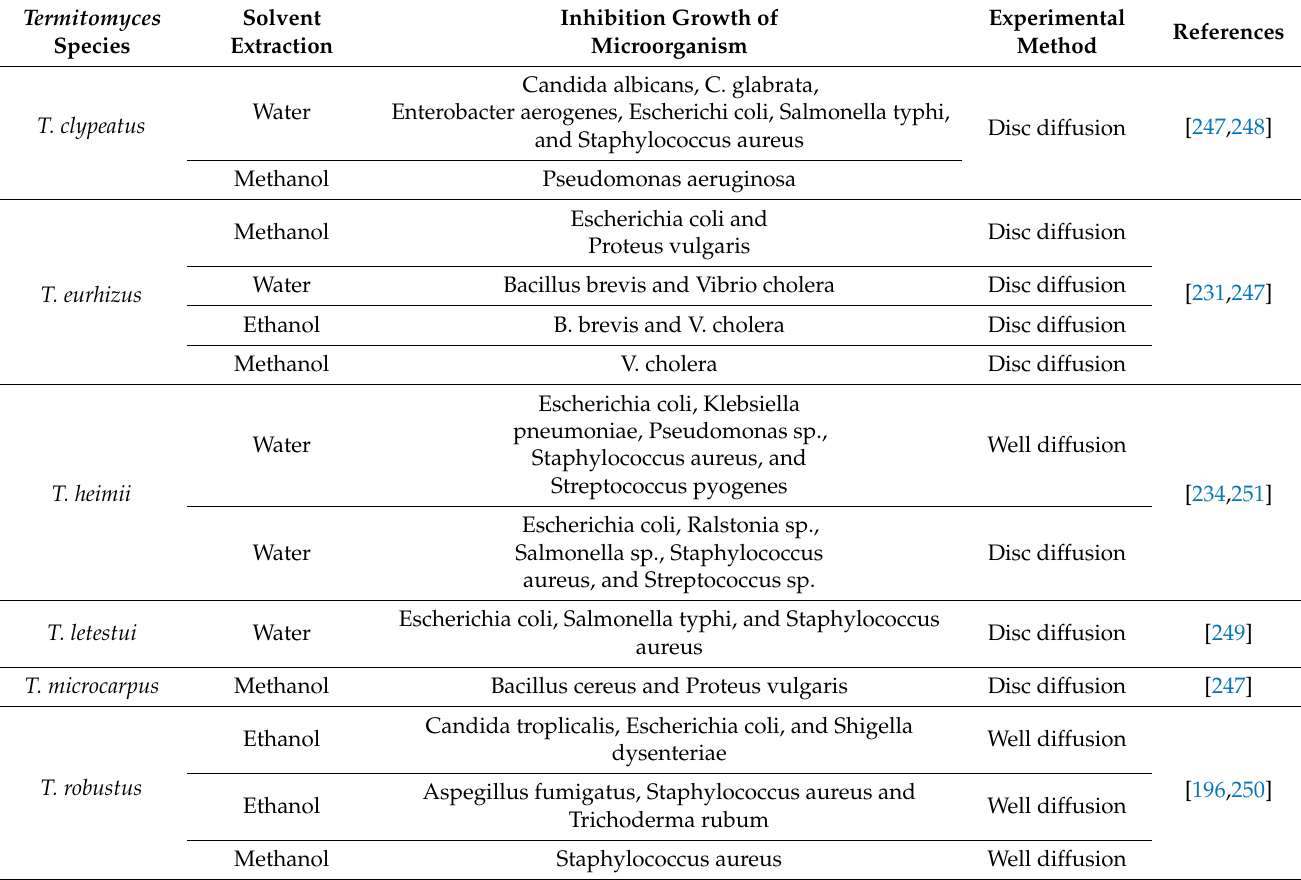
Table 7. Different Termitomyces species with antimicrobial